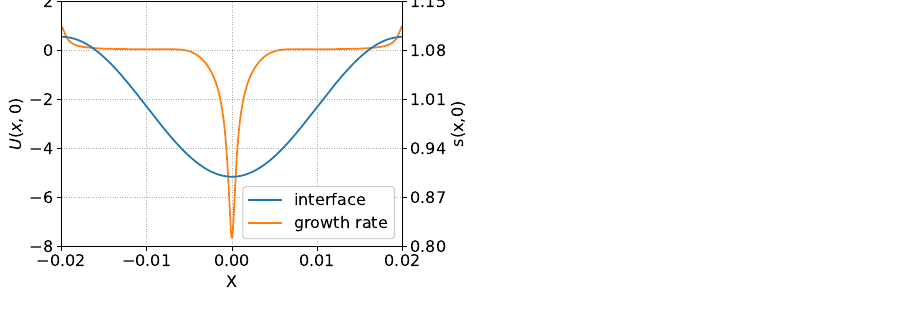
Figure 3. The interface (blue line) and growth rate (orange line) of the perturbations. Perturbation wave length is λ = 0.04, its amplitude is A = 0.1.